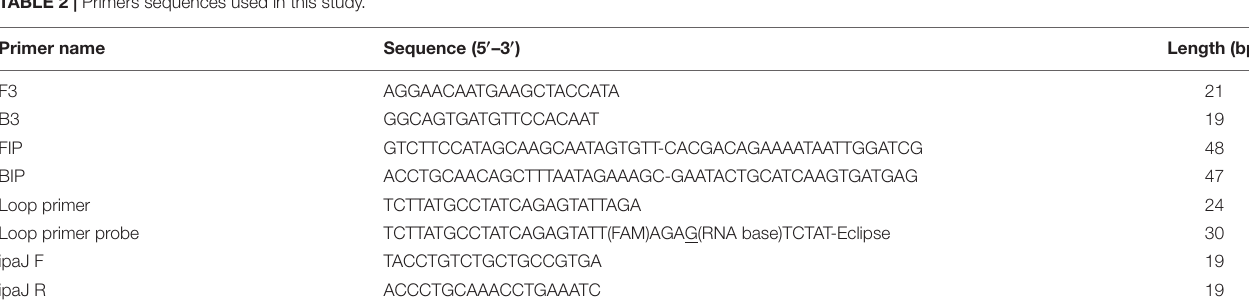
FIGURE 1 | Single-nucleotide polymorphism at the 237th site of the rfbS gene for the Salmonella D serogroup. TABLE 2 | Primers sequences used in this